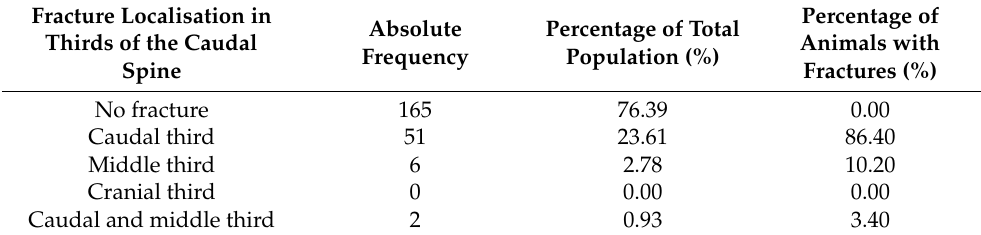
Table 1. Fracture frequency and location within the caudal spine of lambs.